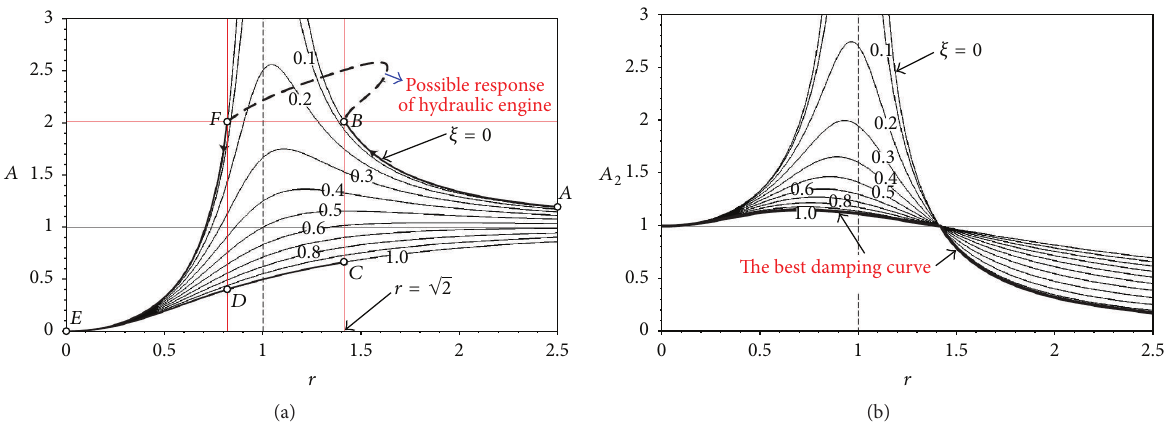
Figure 4: (a) Frequency response of (4) and (b) frequency response of